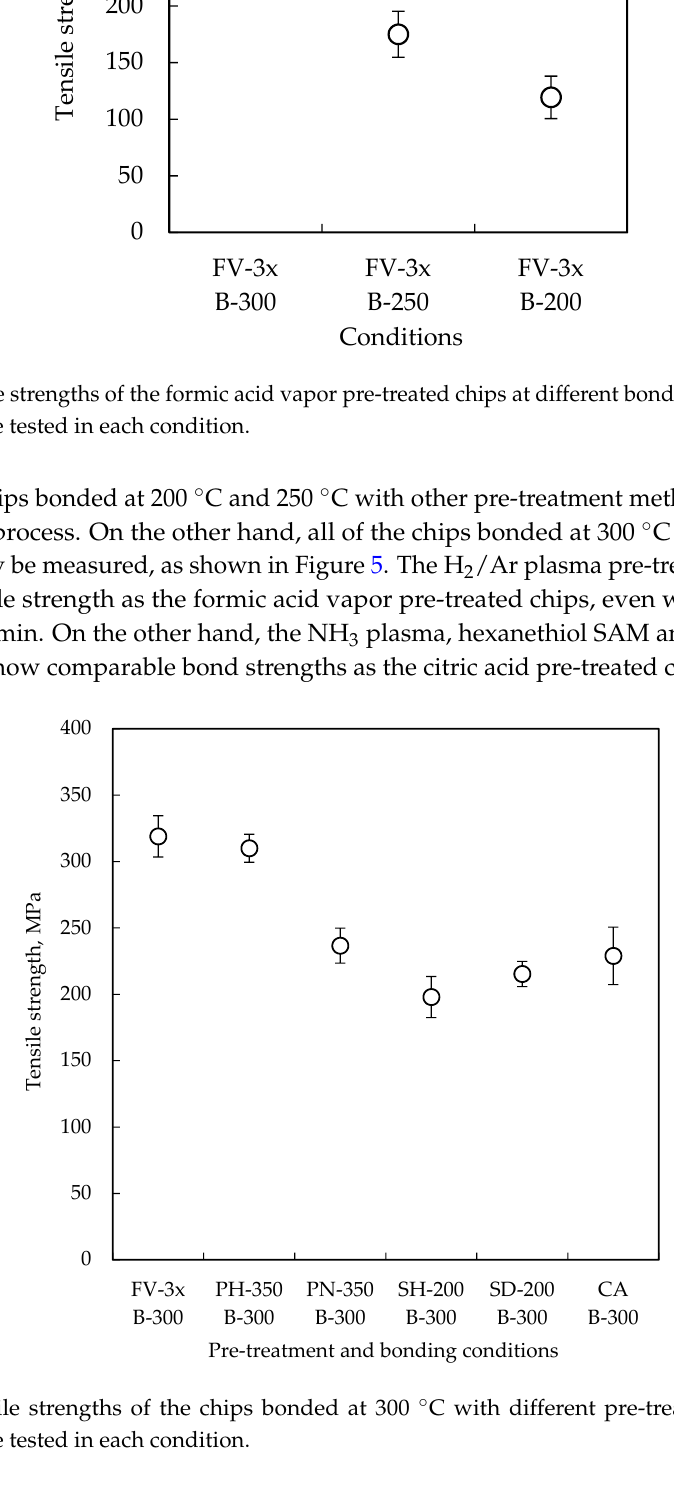
Figure 5. Tensile strengths of the chips bonded at 300 °C with different pre-treatment methods. Nine chips were tested in each condition.